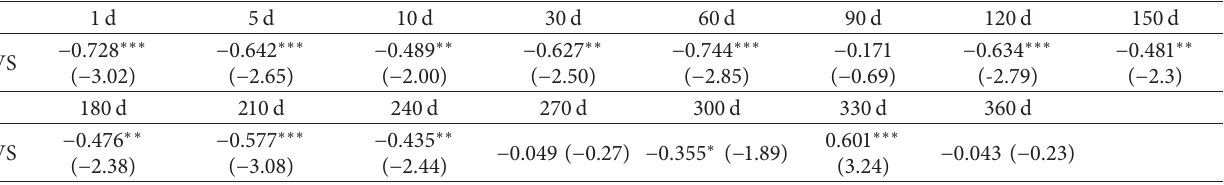
Table 10: Robustness test: based on turnover IVS to predict the liquidity of stock market.